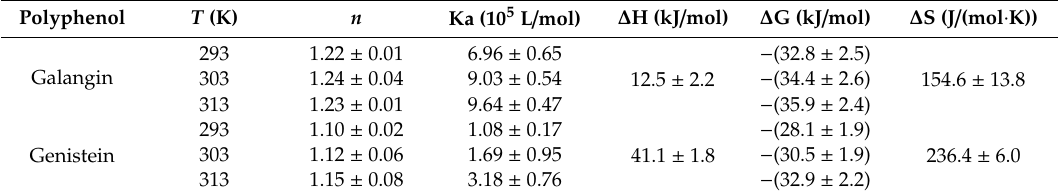
Table 2. The apparent binding parameters (Ka) and three apparent thermodynamic parameters for the non-covalent WPI-galangin / genistein interactions at three temperatures. Polyphenol